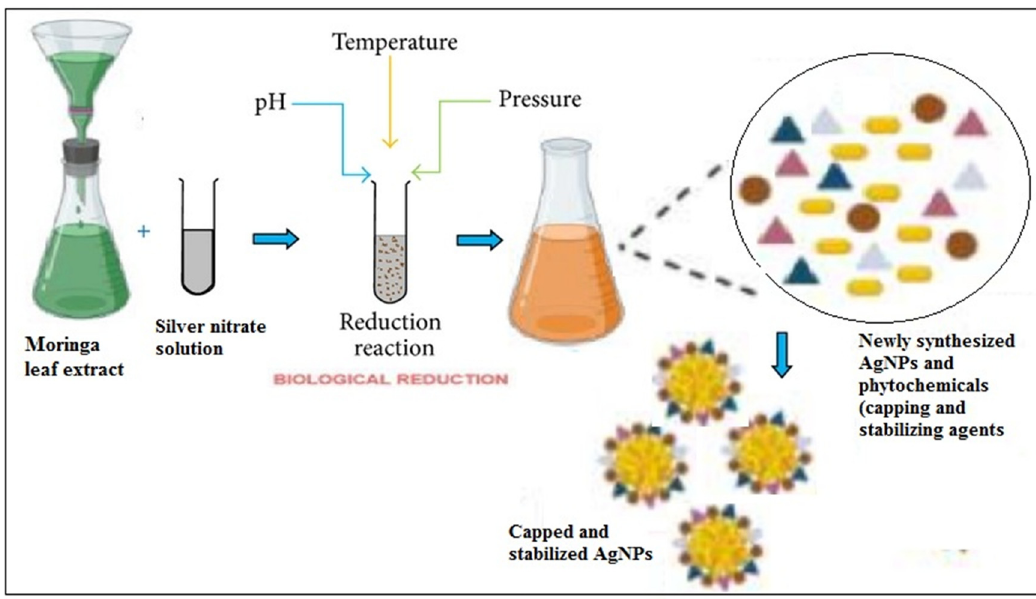
Figure 1: Mechanism of green synthesis, stabilization, and capping of AgNPs.